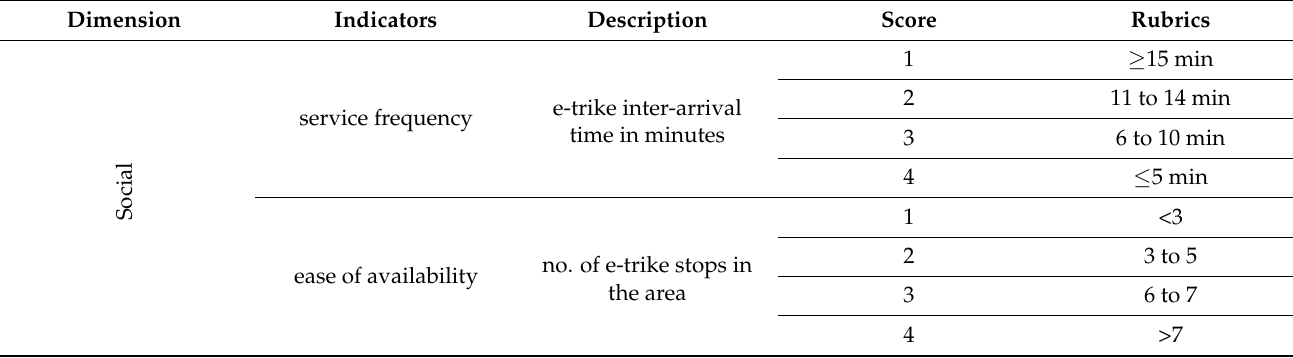
Table 5. Rubrics for e-trike sustainability